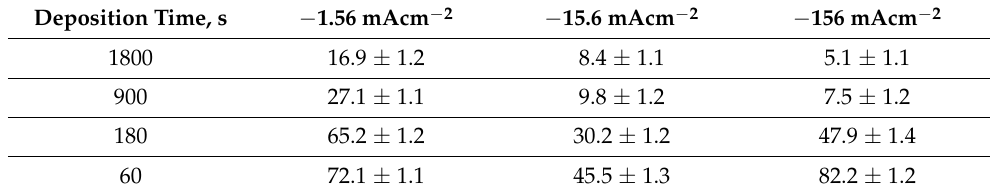
Table 4. The composition of the Pd–Co alloy (Pd%) obtained from dilute solution (about 17% in Pd) at different deposition and current